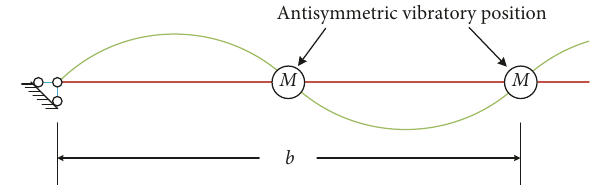
Figure 1: Transverse antisymmetric vibration of the simple sup- ported